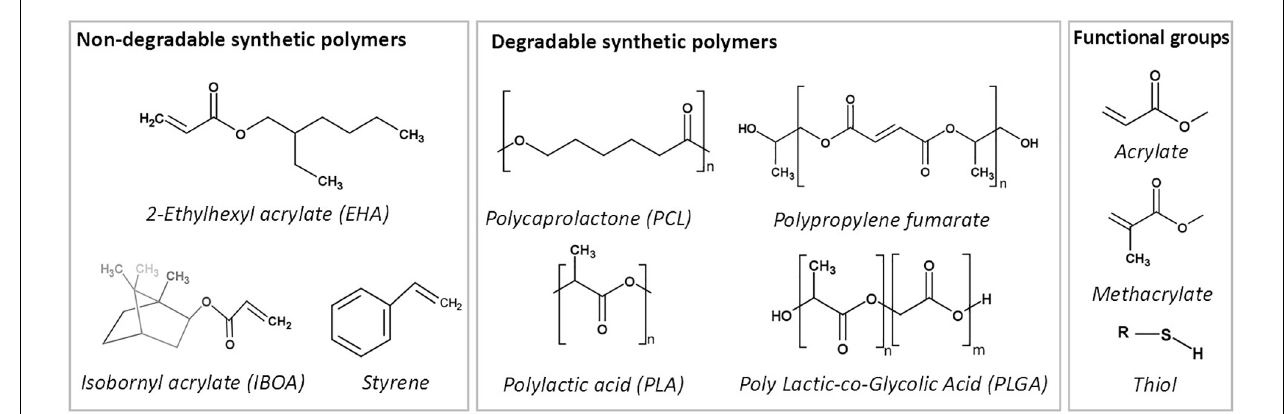
FIGURE 11 | Commonly used synthetic polymers to prepare emulsion templated